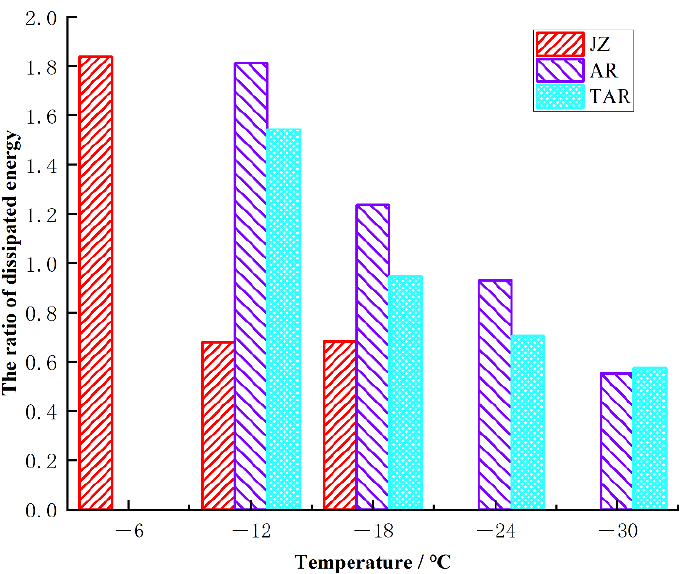
Figure 21. The variations of dissipated energy ratio at different temperatures.